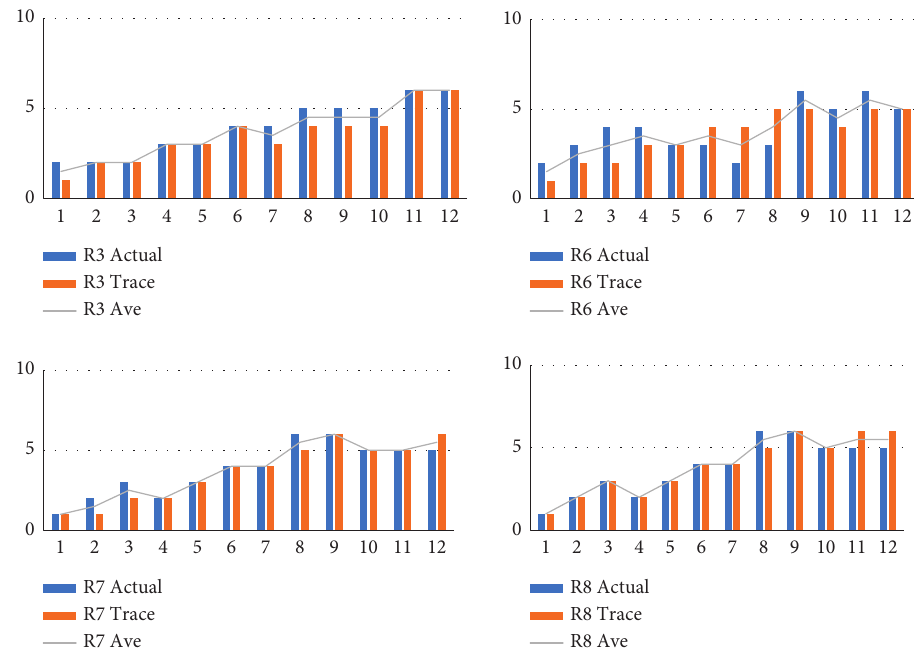
Figure 3: Chart of actual, trace, and average progressions of the pupils identified as small incremental shifters.